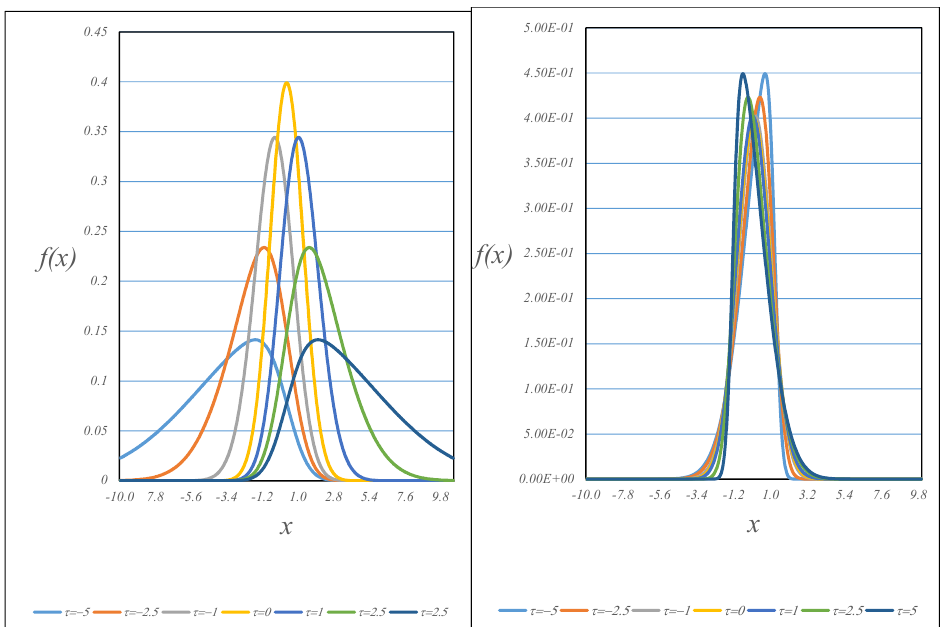
Figure 5. Skew-Normal Standardized Skew-Normal Density Functions.